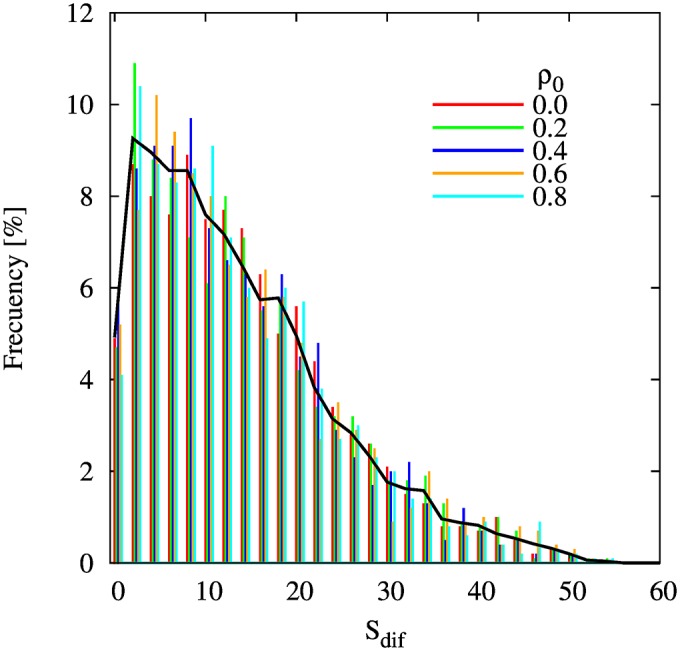
Distribution of size differences Sdif -in per cent points- between the two cliques in a system with N = 100, p = 0.3 and ε = 0.2.Each colored vertical line represents the frequency of clique size differences for a different proportion of positive links ρ0 in the initial conditions, as indicated in the legend. The back curve represents the mean of the previous frequencies. We run 1000 simulations for each ρ0 value. Each vertical line represents the frequency in 2% bins and the different cases has been shifted each other to facilitate visualization.